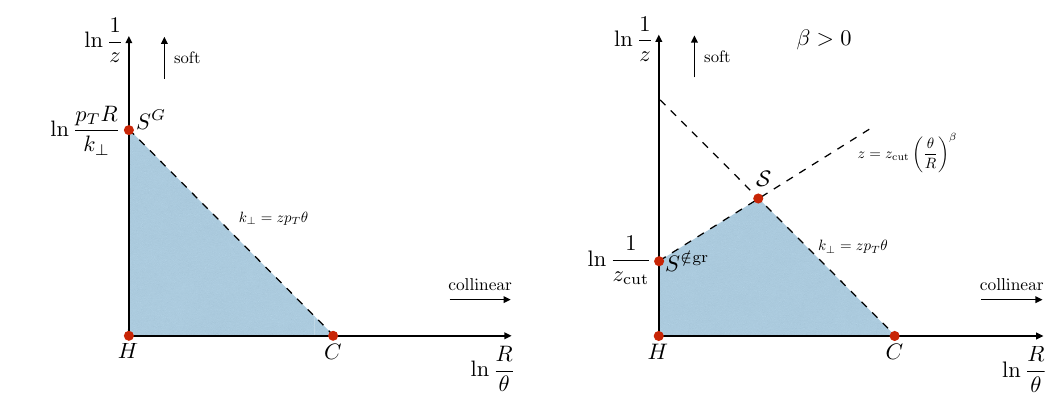
Figure 2 . Lund diagrams for the angle between the standard and the WTA axis (left) and the groomed and the WTA axis (right). The modes that appear in the factorization for these two observables are indicated with red dots, whose parametric scaling can be read o(cid:11) from this